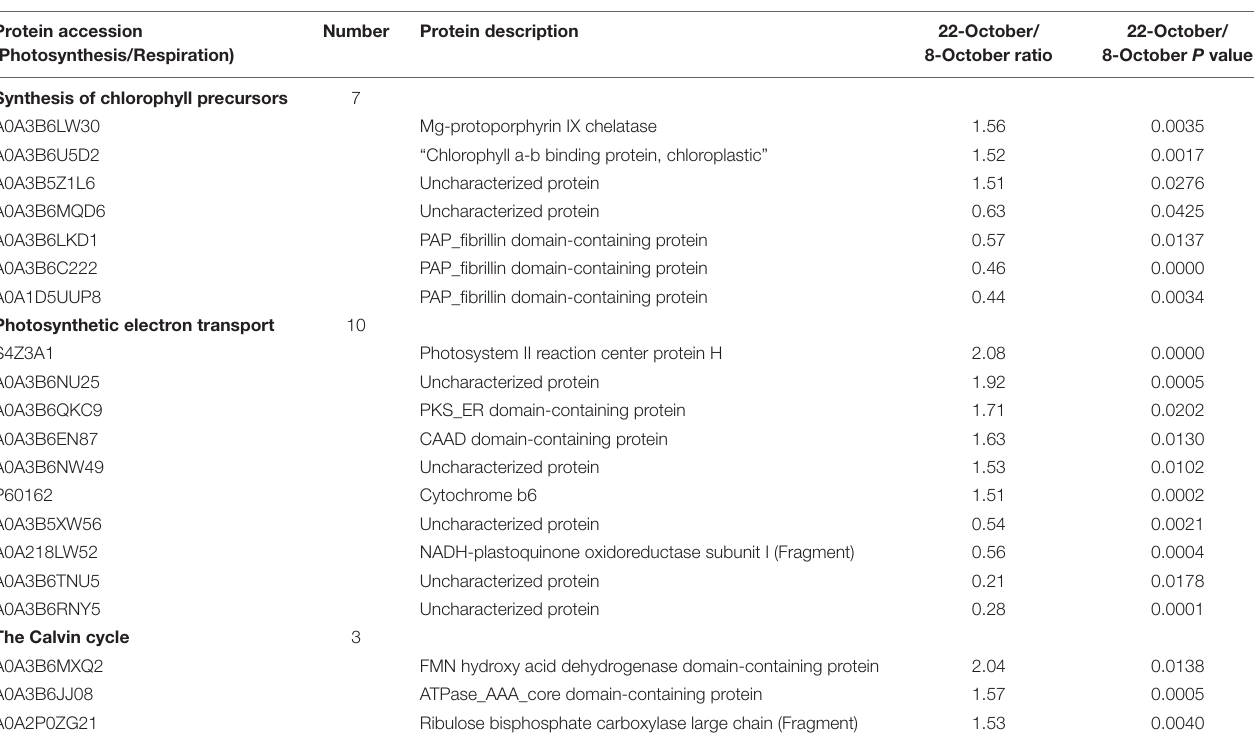
TABLE 3 | Photosynthesis-related proteins differentially expressed under heat stress at late wheat grain–filling stage. Protein accession